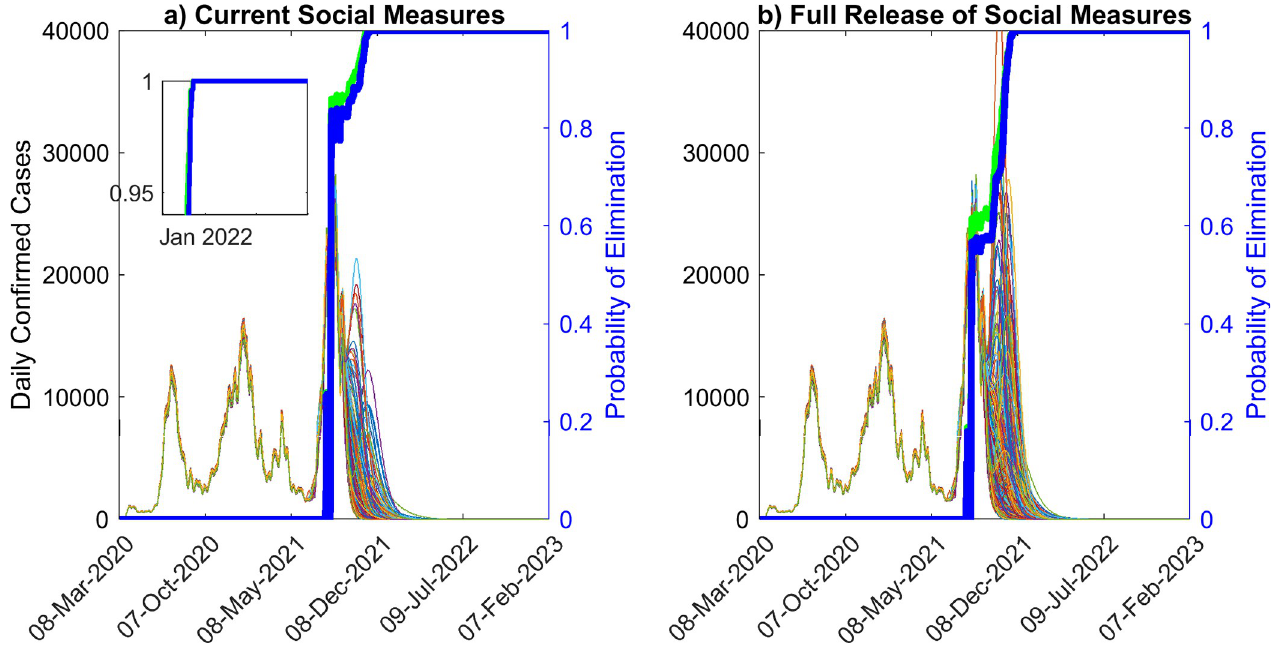
Fig 5. Model ensemble and probability of elimination over time, given long-term immunity. Ensemble of predictions of daily confirmed cases, and probability of elimination over time, assuming long-term immunity, given a) estimated social measures as of Sept. 24 th , 2021 and b) after the full release of social measures. The predictions of the model ensemble (250 in total, see Methods) are represented by the thin curves in the background of the figure. Given the estimated social measures and vaccination rate as of Sept. 24 th , 2021, the probability of fadeout is given by the blue curves, whereas increasing vaccination to 1.5x is presented by the green curves, respectively. If estimated social measures are continued along with the vaccination rate as of Sept. 24 th 2021, 99% probability of elimination will be achieved on Nov. 13 th 2021, while if social measures are fully released, 99% probability of elimination will be achieved on Nov. 22 nd 2021. With a 1.5x increase in vaccination, the corresponding 99% probability of pandemic fadeout will be achieved on Nov. 8 th 2021 and Nov. 19 th 2021 for continuing with estimated social measures and given a release of social measures, respectively. Even though there is a significant probability of resurgence given a full release of social measures, the size of the wave is likely to be very